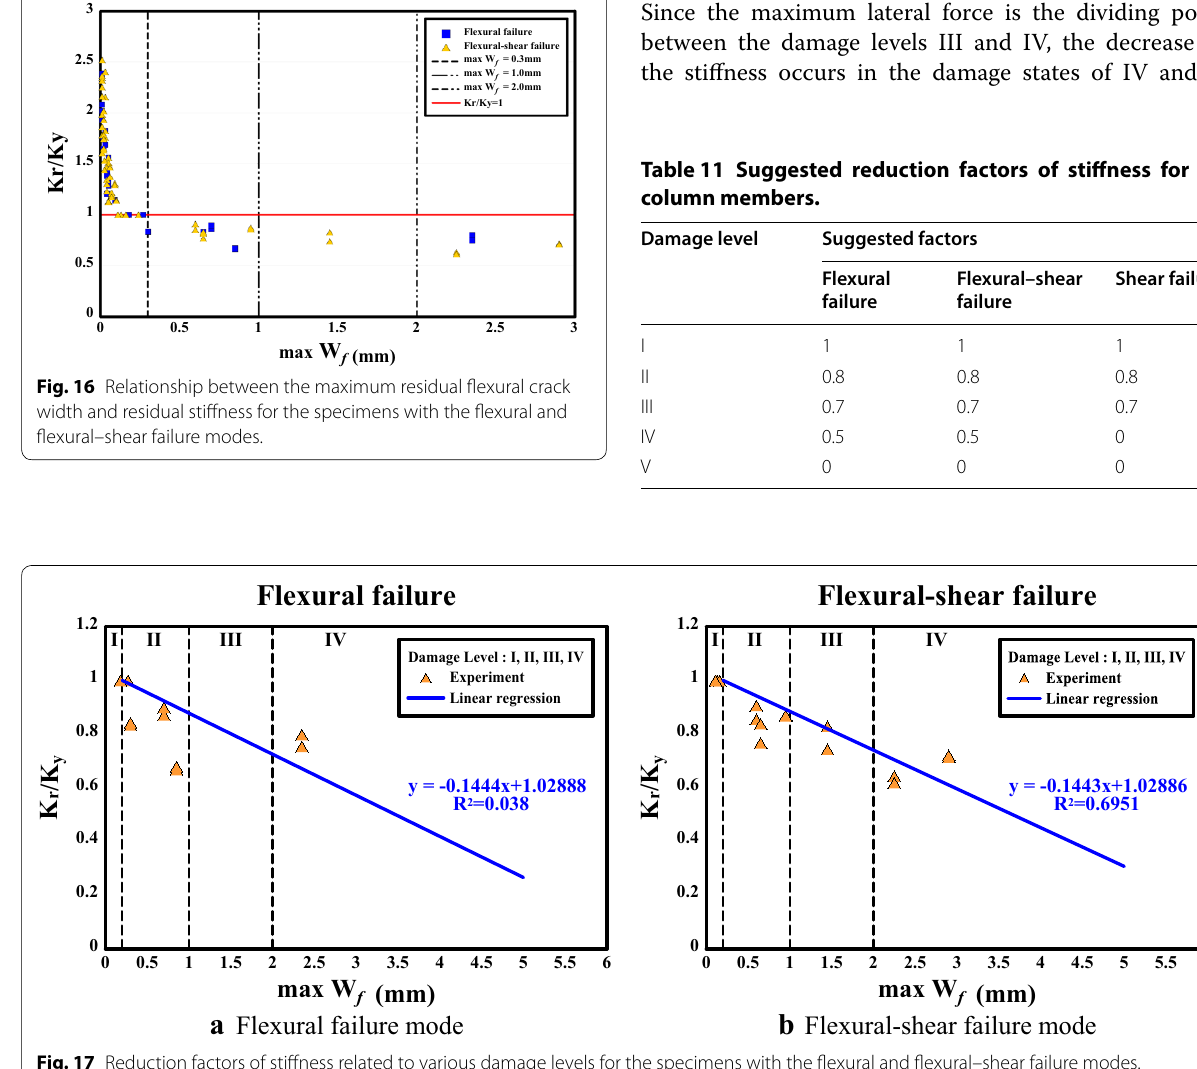
Fig. 17 Reduction factors of stiffness related to various damage levels for the specimens with the flexural and flexural–shear failure modes.